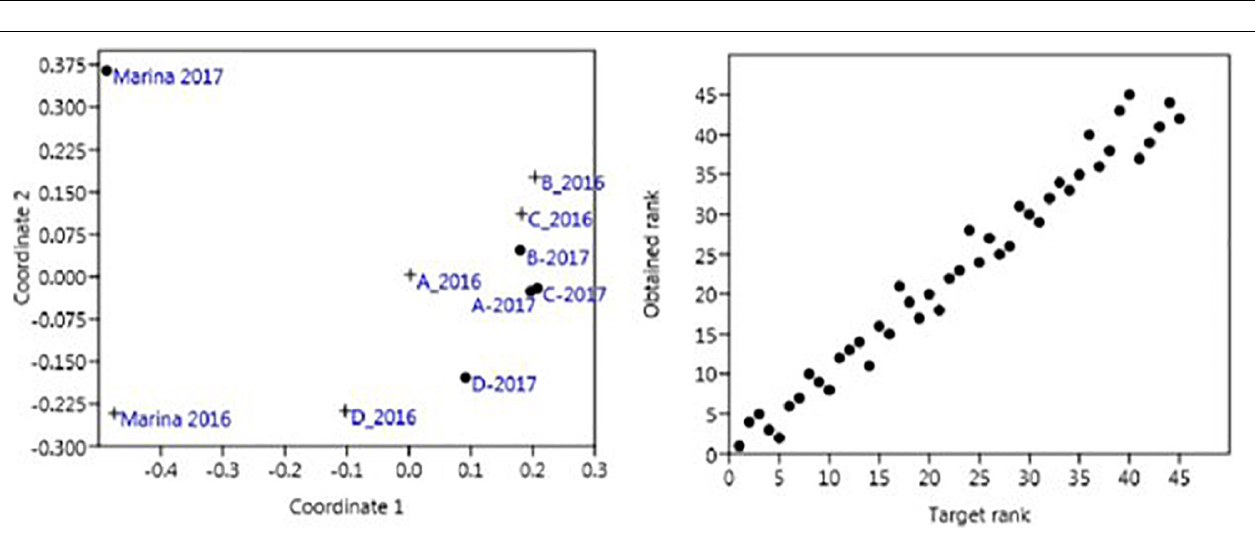
FIGURE 4 | Diversity rarefaction plots of ( A ) all observed species and ( B ) non-indigenous species from the port of Gijon, Bay of Biscay, Spain.